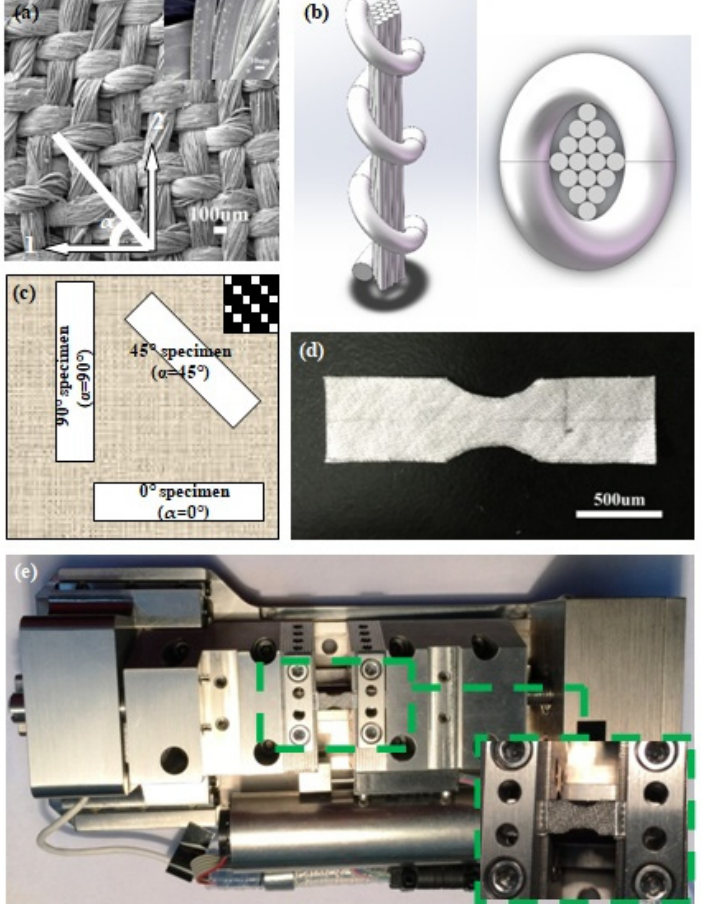
Figure 1. ( a ) Structure of the fabric, with the principal directions marked as 1 and 2. The image was captured by SEM, and the inset shows the detail of polyester fibers and an MGF; ( b ) A schematic of the bundle structure in 3D view and an overhead view; the orientation of the tensile specimens extracted from the original sheet is shown in ( c ), and the inset depicts the 1/2 twill fabric weave patterns; ( d ) A specimen used in the tensile experiment; ( e ) Miniature tension test frame with a composite specimen mounted.